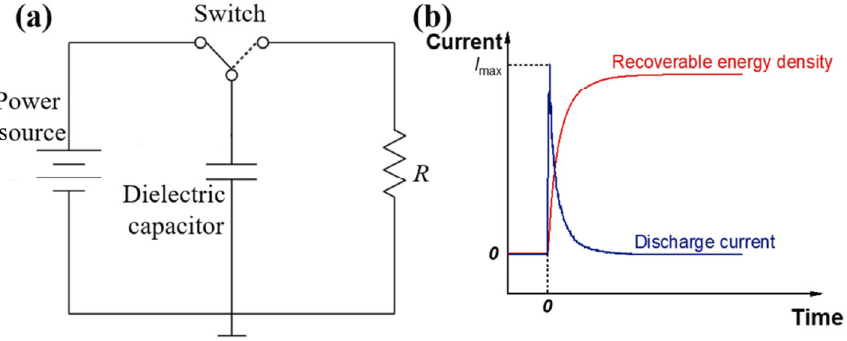
Fig. 3 (a) Schematic diagram of the charge–discharge circuit. (b) Discharge current and corresponding calculated Reproduced with permission from Ref. [12], © Elsevier Ltd.